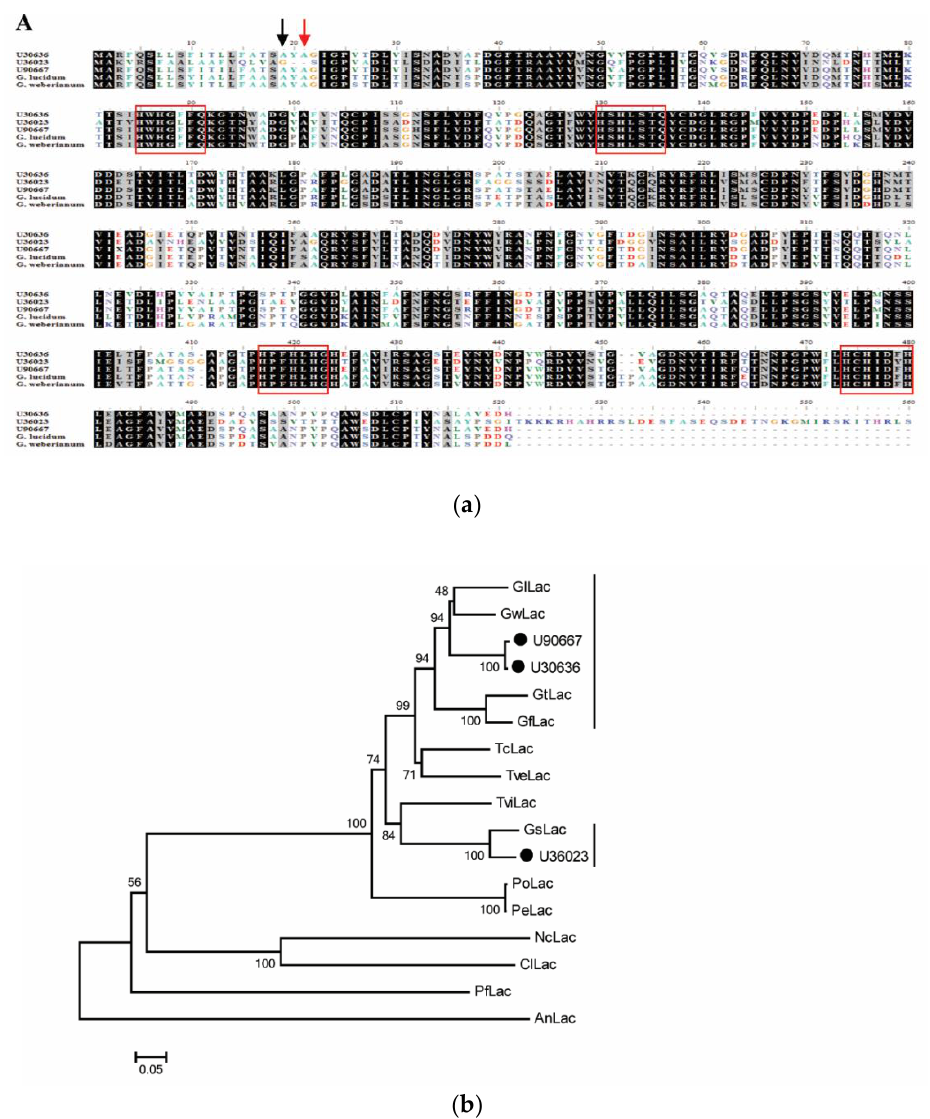
Figure 2. Sequence alignment and phylogenetic tree of GbLacs. ( a ) Multiple alignment of GbLac protein sequences from G. boninense , G. lucidum (Accession number: AHA83584.1) and Ganoderma weberianum (accession number: ANA53145.1). The cleavage sites of predicted signal peptide for U30636 and U90667 (red), and U36023 (black) are indicated with arrows. Red rectangles show copper-binding domains. The conserved amino acid is shown with black background. The accession numbers for Lacs from G. lucidum (ACR24357.1) and G. weberianum (ANA53145.1) are in parentheses. ( b ) The neighbor-joining tree of deduced amino acid sequences of Lac from G. boninense PER71 and other fungal Lacs. Numbers at the branches show bootstrap support of 1000 replicates. The tree is drawn to scale, with branch lengths having the same units to evolutionary distance denoted by the horizontal bar (0.05 amino acid substitution per site). Lac sequences obtained from this study are labeled with black circles. Abbreviations of Lacs from: Aspergillus niger (AnLac, GAQ36284.1); Curvularia lunata